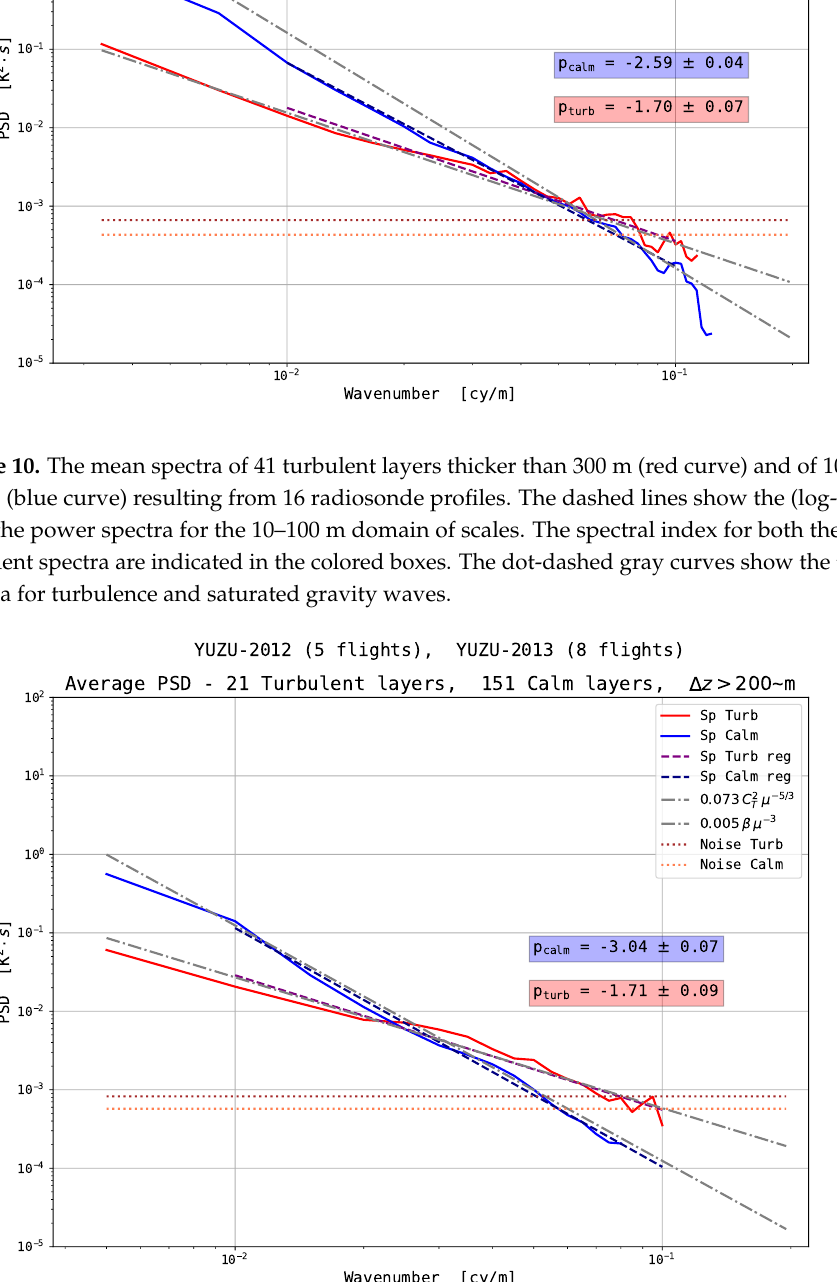
Figure 11. Same as Figure 10 but for 10 flights of the Y12 and Y13 campaigns. Layers thicker than 200 m are retained. The mean spectra of 20 turbulent layers(red curve) and of 236 laminar layers (blue curve) resulting from 10